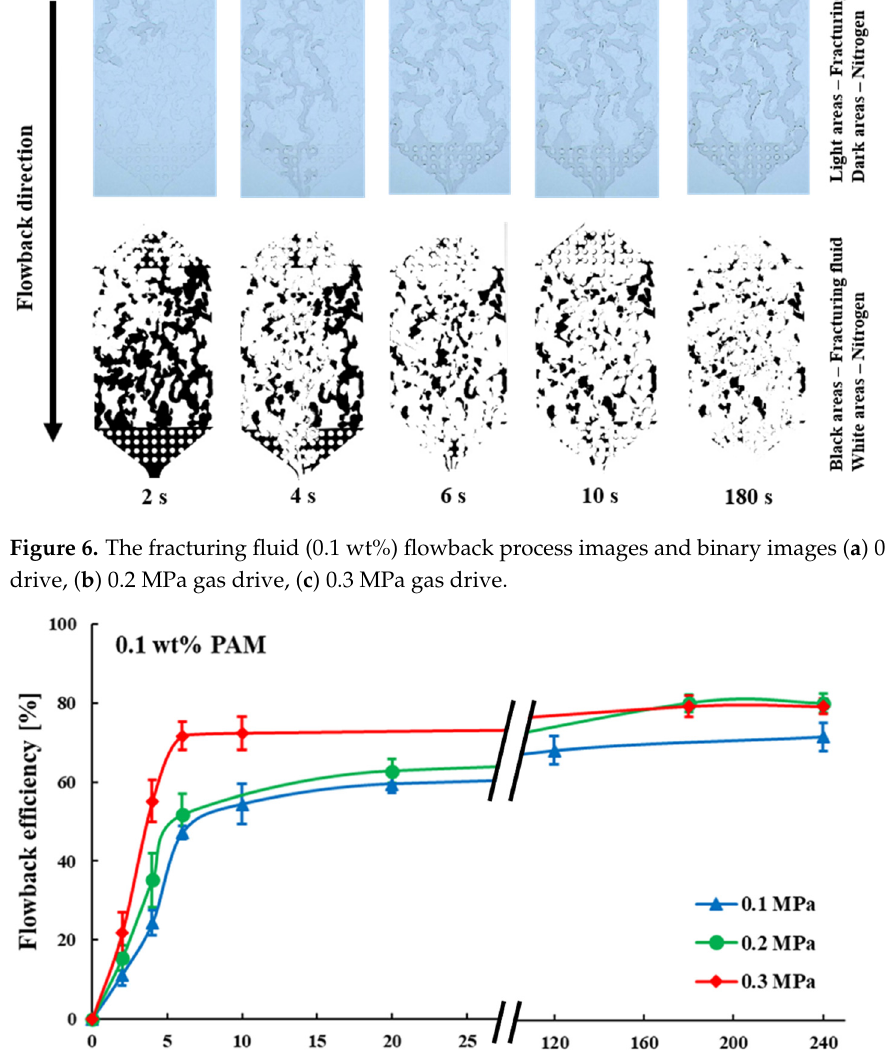
Figure 7. Relationship between time and fl owback e ffi ciency of fracturing fl uid (0.1 wt%).